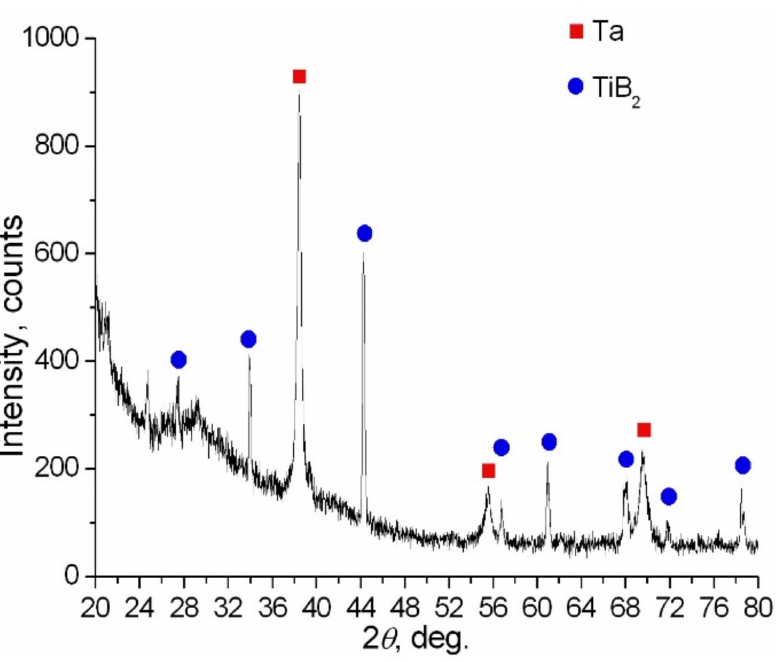
Figure 13. Diffraction pattern for the cross section of composite derived from Set 3 .